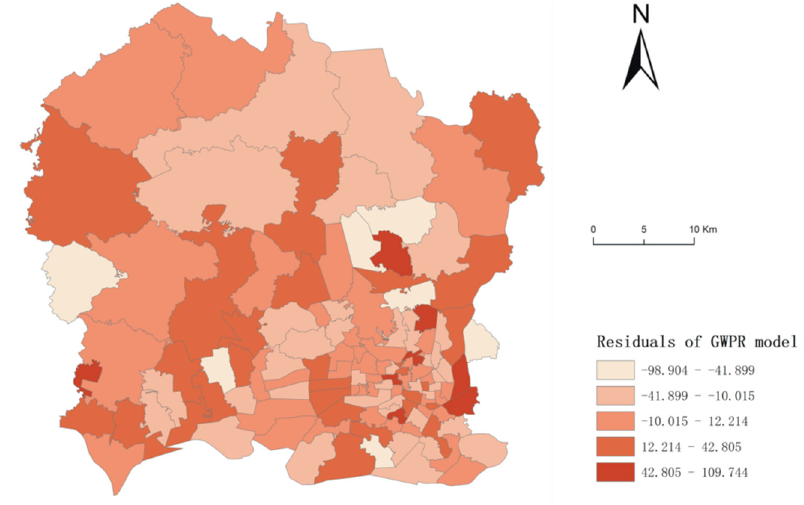
Figure 2. Residuals of geographically weighted Poisson regression (GWPR) model by PSMA.